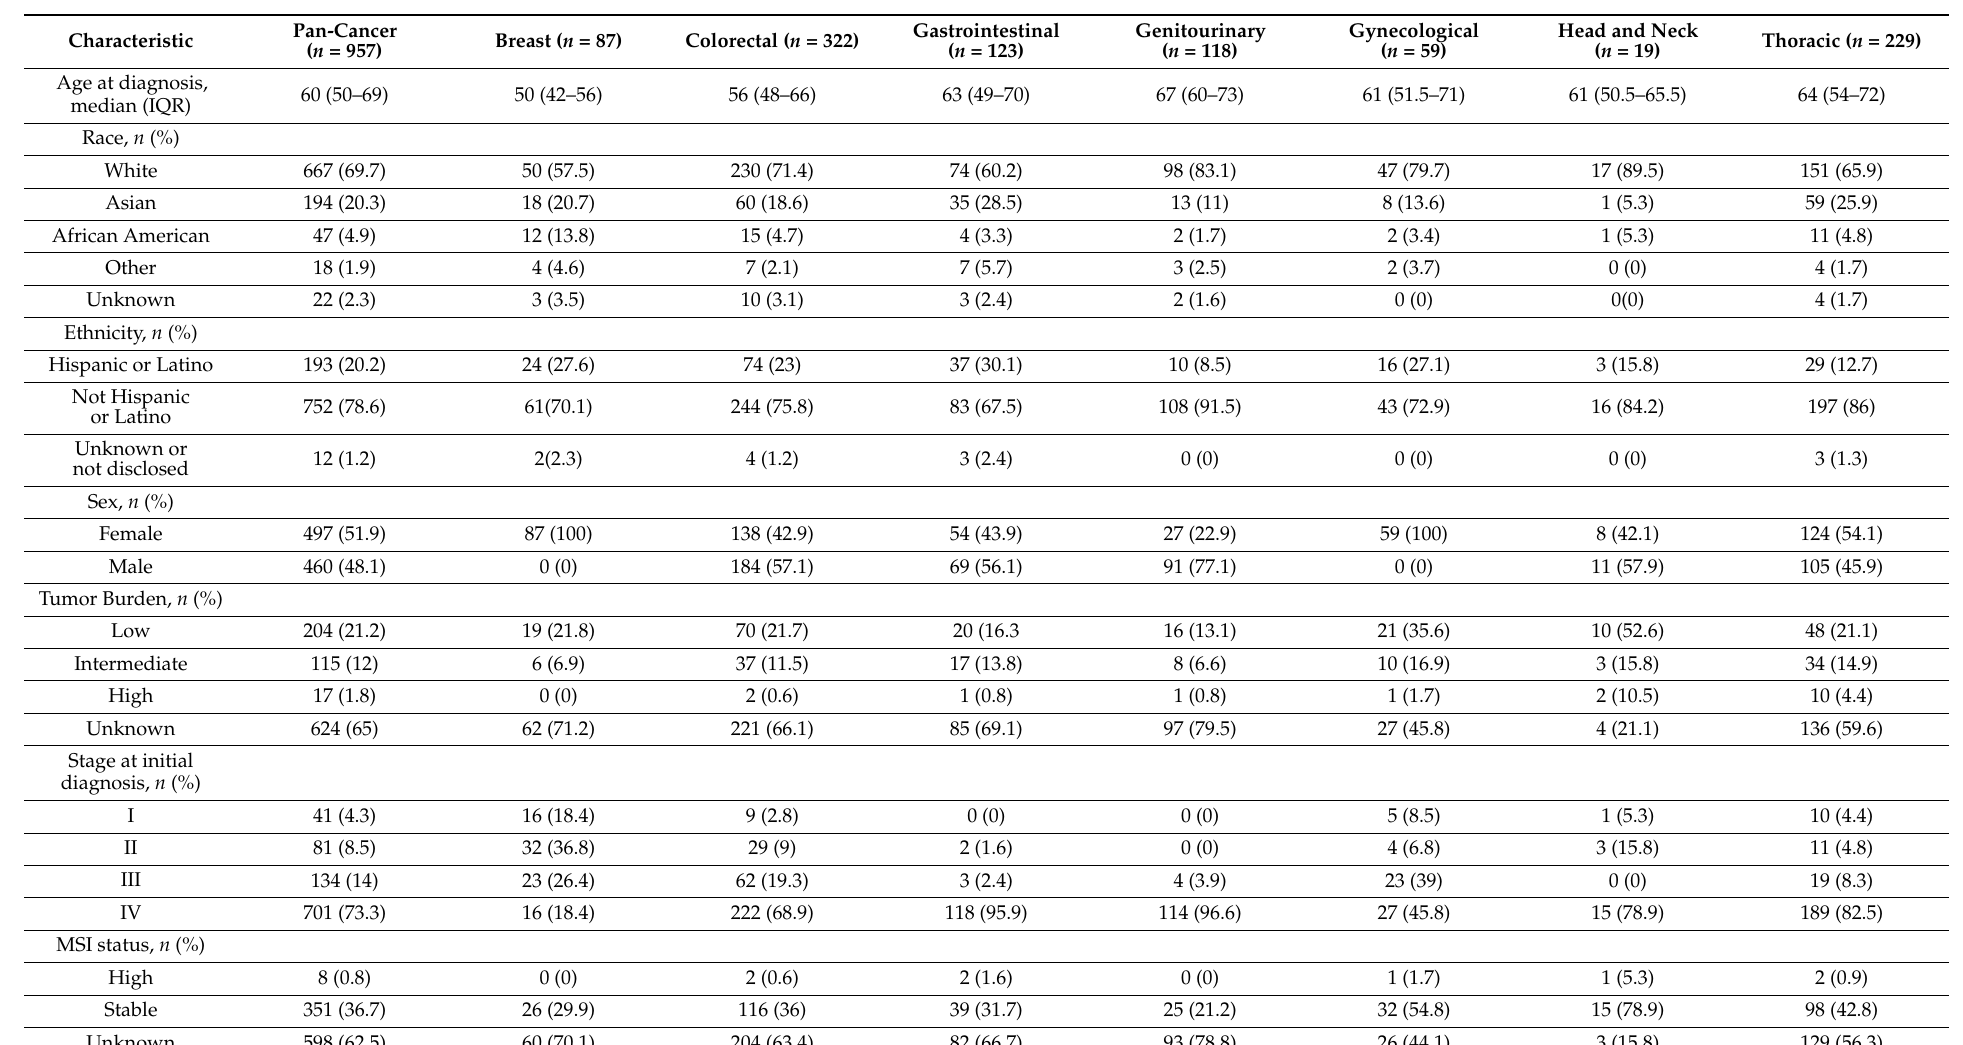
Table 1. Baseline characteristics of 957 patients with seven metastatic solid cancers. IQR: interquartile range; MSI: microsatellite